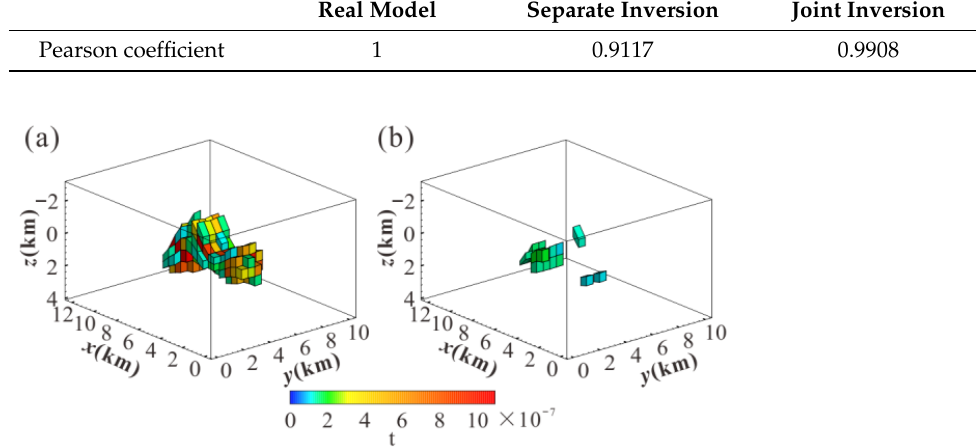
Table 9. Pearson correlation coefficients of inversion results.